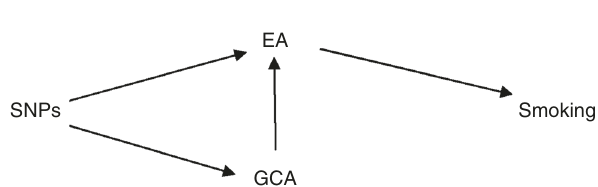
Fig. 1 Relationship between education, cognitive ability and smoking suggested by the results obtained. DAG for the relationship between educational attainment, general cognitive ability and smoking suggested by the results obtained. DAG directed acyclic graph